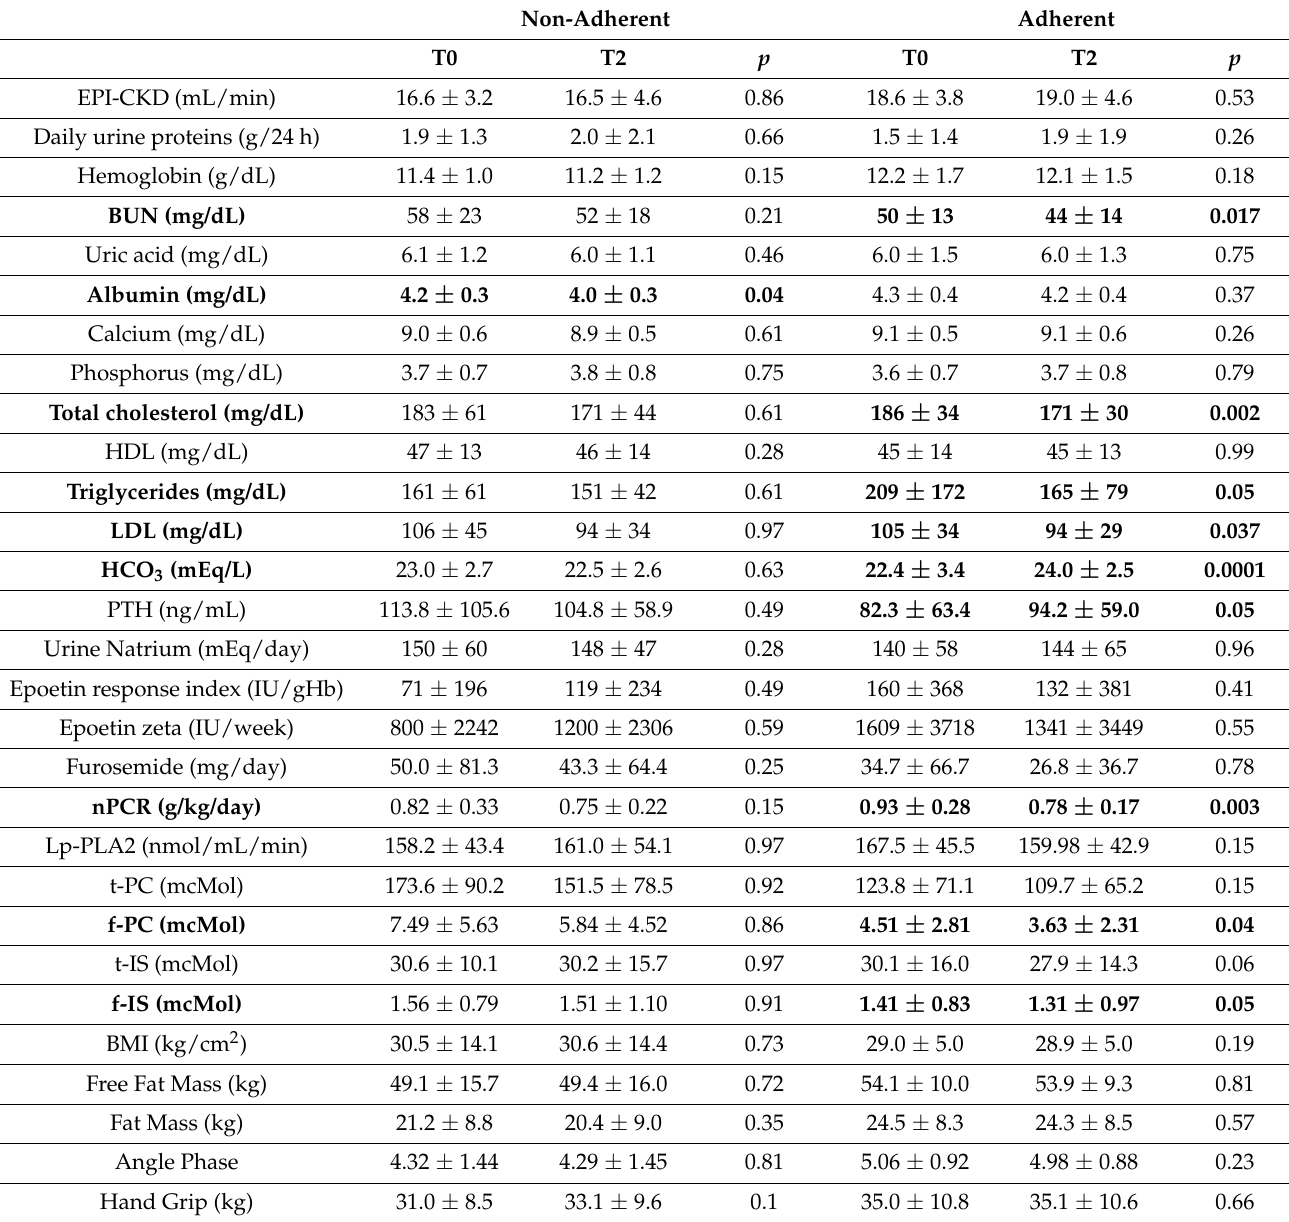
Table 2. Comparison between biochemical and nutritional parameters and pharmacological therapy in non-adherent and adherent